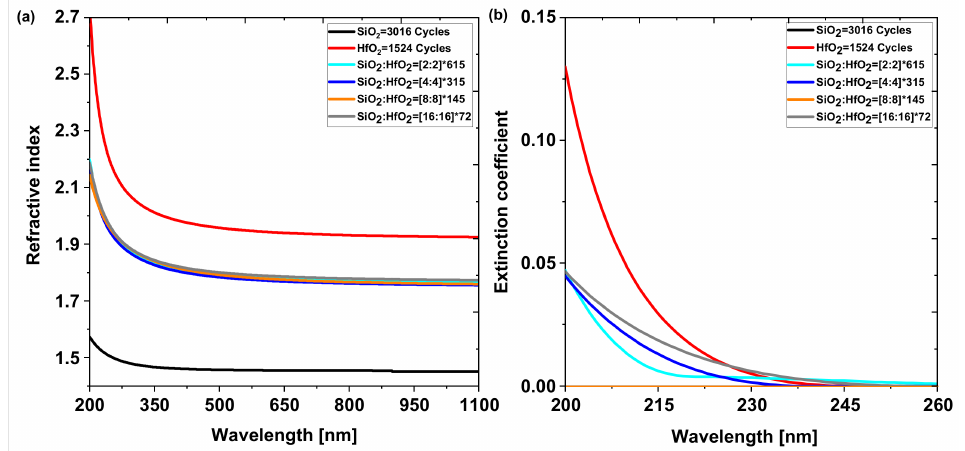
Figure 3. Optical constants (( a ) refractive indices and ( b ) extinction coefficients) for the heterostruc- tures with identical cycle ratios of the